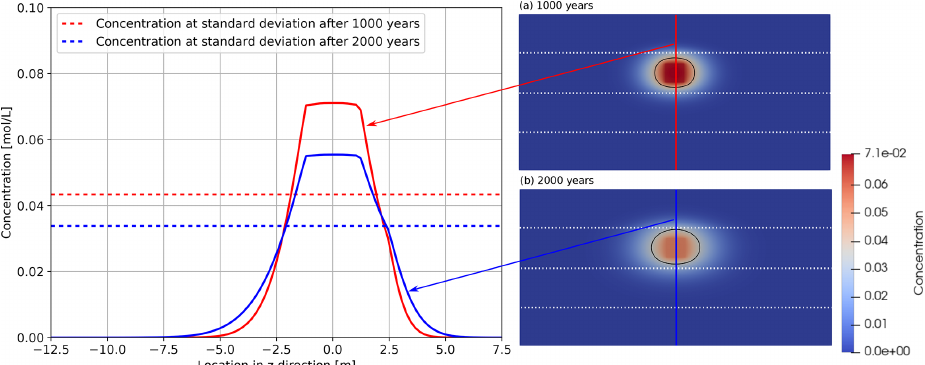
Figure 4. Na + concentration profiles along z direction after 1000 years’ (red line) and 2000 years’ (blue line) diffusion. Subsets show the concentration distribution in the entire domain after 1000 years’ (a) and 2000 years’ (b) diffusion. Red line (a) and blue line (b) are utilized to compare the concentration profiles along z direction. The canister center is located in the position: z = 0m. The white dashed lines represent boundaries between different layers. Black line represents diffusion front.